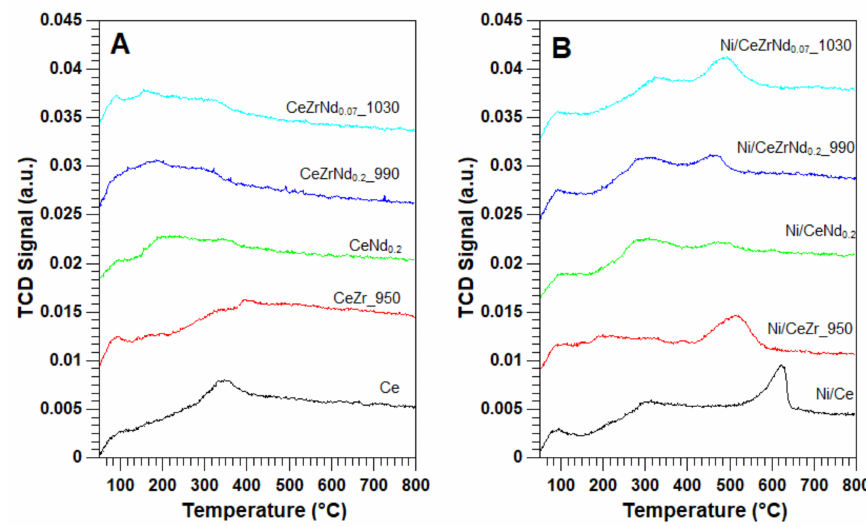
Figure 7. CO 2 -TPD profiles of supports ( A ) and Ni catalysts ( B